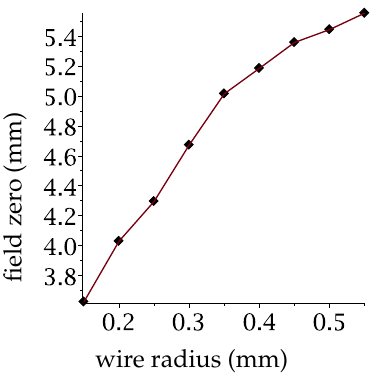
Figure 4. How the radius of the wire affects the distance from the wire at which the longitudinal field E z passes through zero. This result was calculated using periodic boundary conditions for an infinite rectangular array of uniform and infinitely long